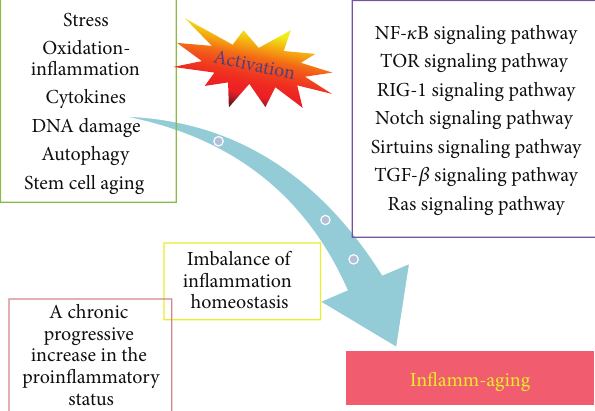
Figure 2: The mechanisms and regulated signaling pathways of